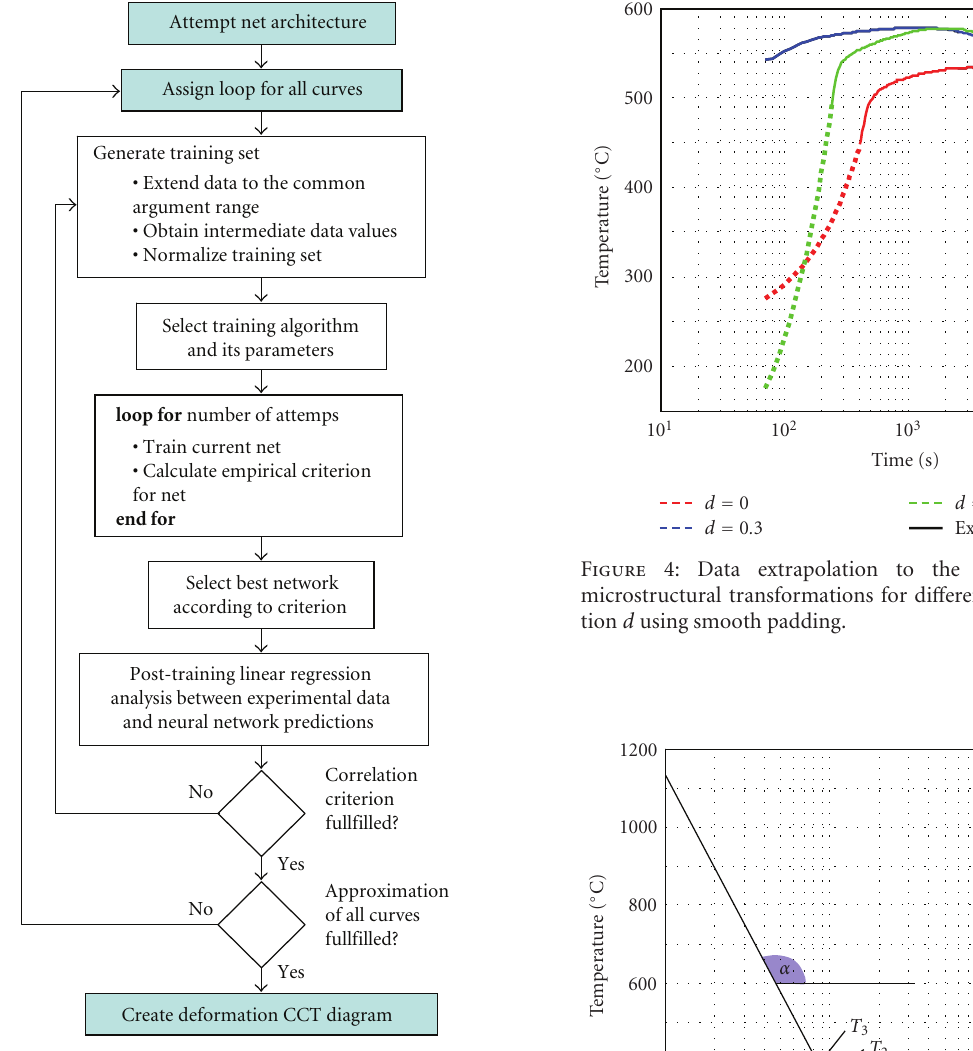
Figure 3: Scheme of the approach for predicting CCT diagrams.